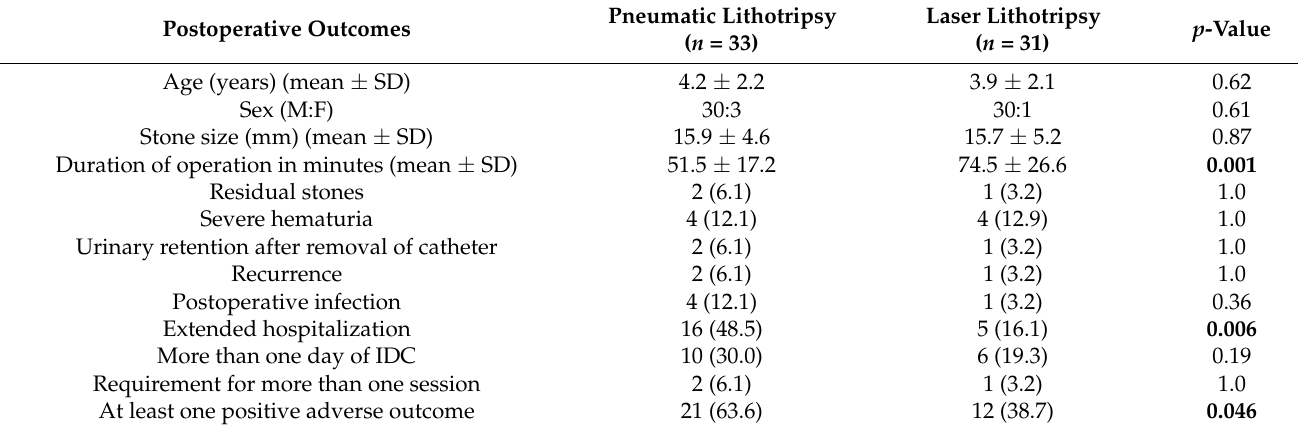
Table 1. Demographics and clinical data in both treatment